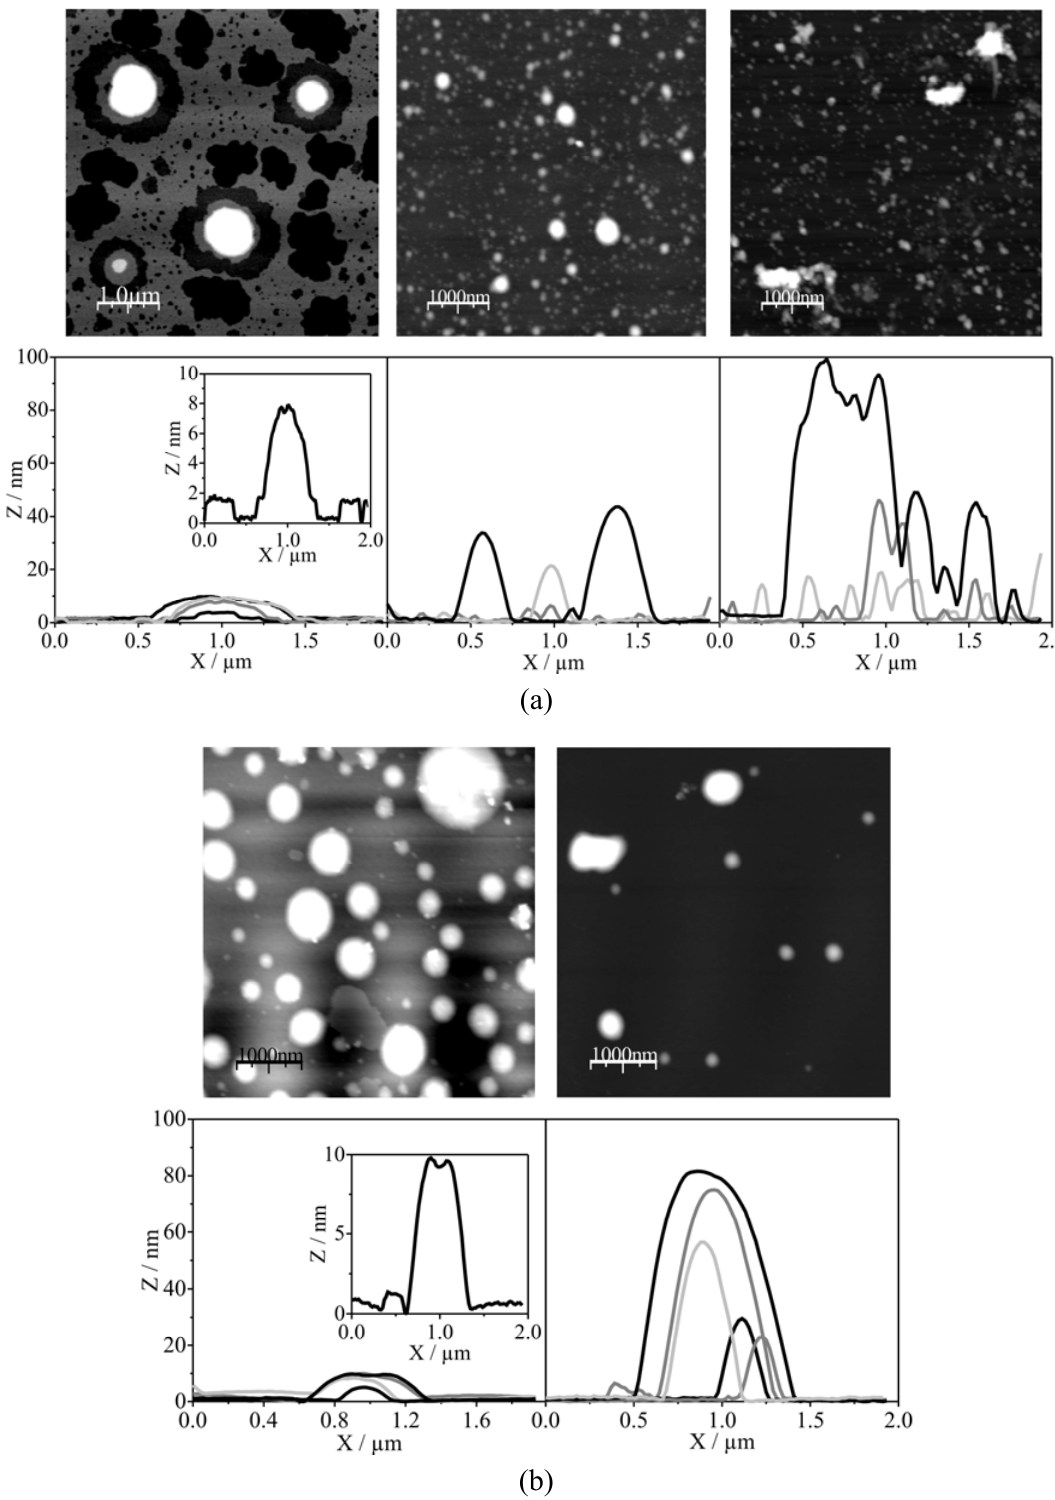
Figure 5. AFM images and some surface profiles of PECs adsorbed onto mica, ( a ) PECs prepared by procedure a—PC is starting solution (left Eth/Eth, mid Isob/Isob, right Styr/Styr); ( b ) PECs prepared by procedure b—PA is starting solution (left Eth/Eth, right Isob/Isob). All n /n ratios of the PECs were − +